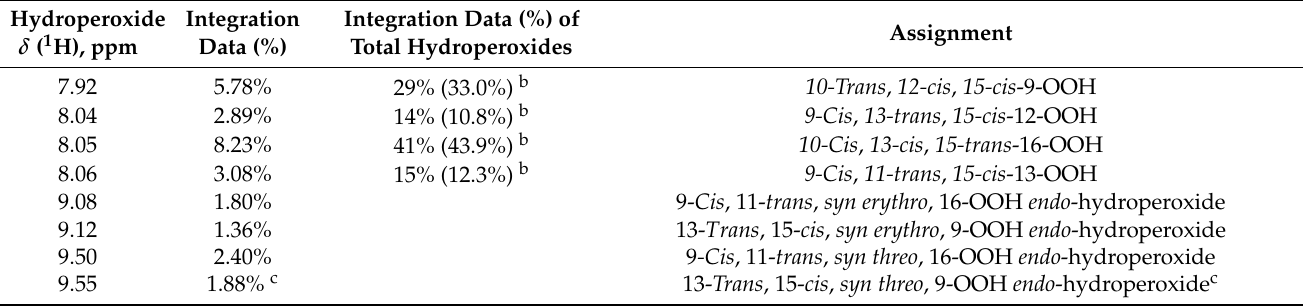
Table 8. 1 H-NMR quantification data of hydroperoxides and endo -hydroperoxides produced during the oxidation of methyl linolenate [138] a .